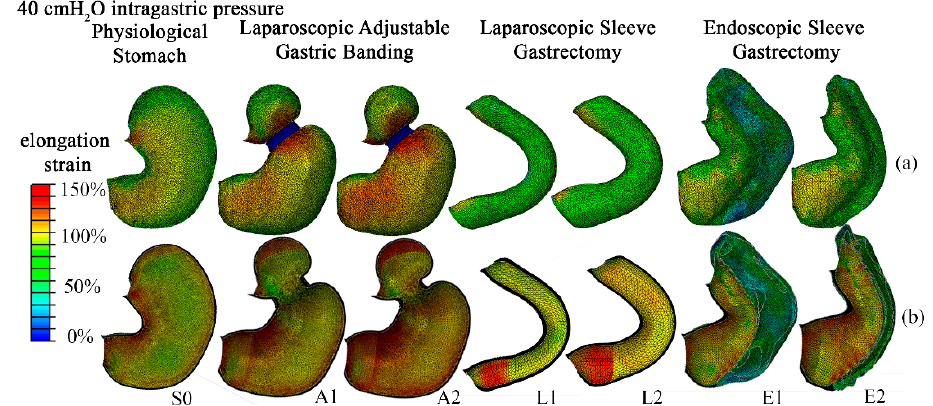
Figure 6. Contours of stomach distension as tissue elongation strain at 40 cmH2O intragastric pressure: comparison of results for physiological stomach (S0), laparoscopic adjustable gastric banding (A1, A2), laparoscopic sleeve gastrectomy (L1, L2), and endoscopic sleeve gastroplasty (E1, E2) for the outer ( a ) and inner layers ( b ).